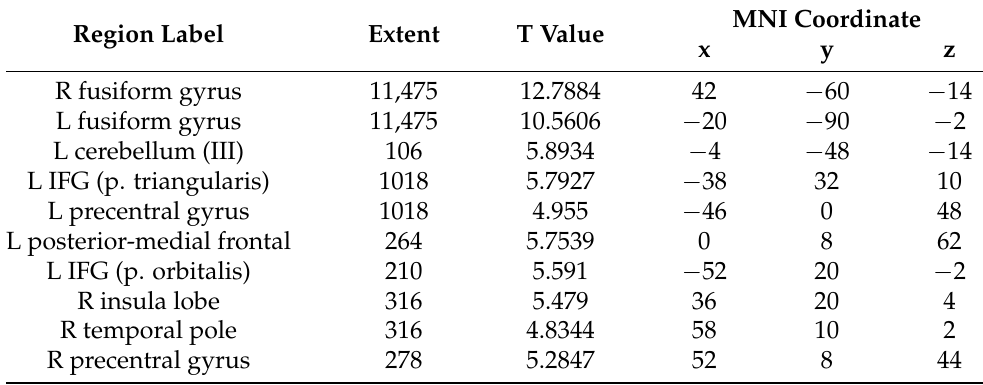
Figure 2. Whole brain activation patterns for the HC group ( p value < 0.001, uncorrected). Table 2. Activation of brain regions for the HC group ( p value < 0.001,